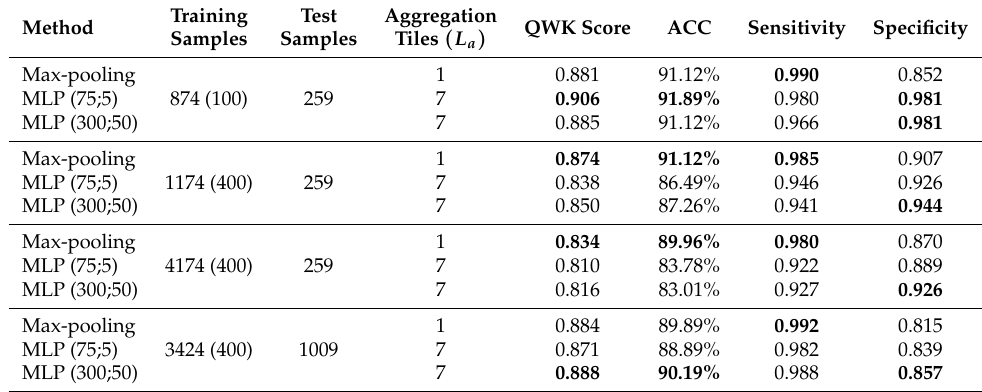
Table 4. Model performance evaluation with increasing training sets and/or annotated samples (in parenthesis). Both the ACC and the QWK score were computed for a three-classes problem, whereas the sensitivity and the specificity were computed for a binary classification problem by considering the LG and HG classes as one unique class. In bold are the best results per